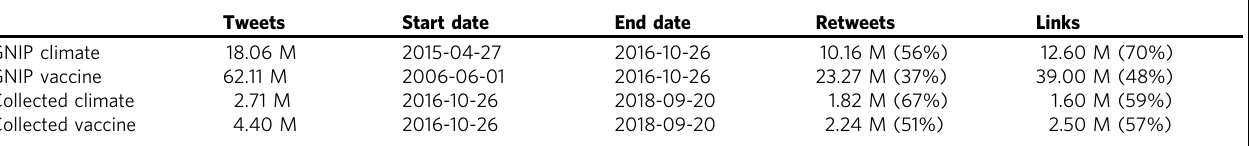
Table 1 Description of